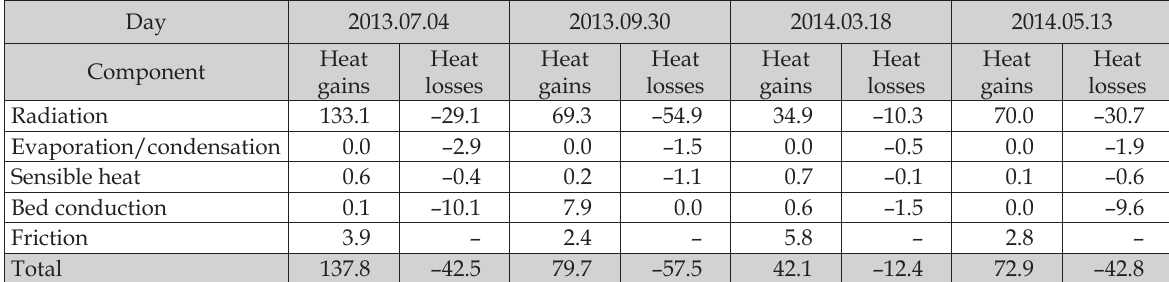
Table. 3. Absolute average heat gains and losses in diurnal energy budget of the Świder River (in W∙m –2